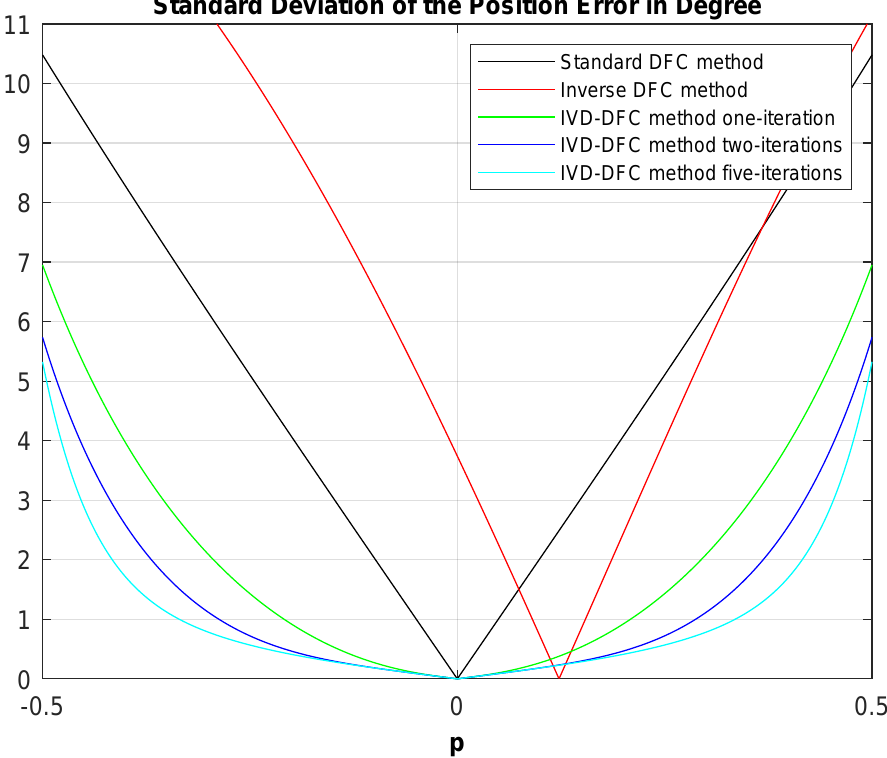
Figure 11. Same as in Figure 5. In this case ˆ ϕ b differs from ϕ b about 5